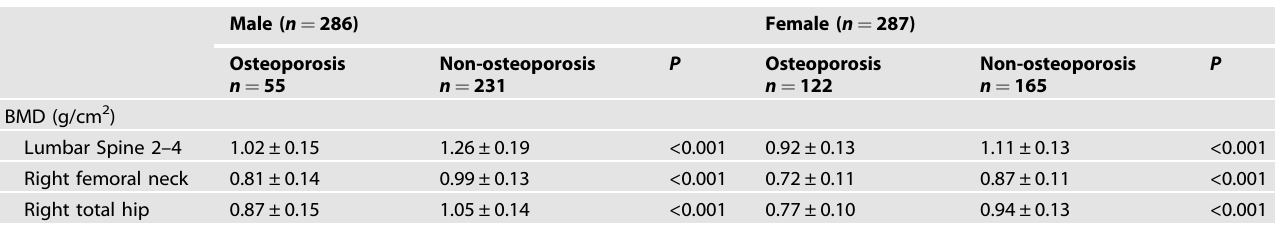
Table 2. BMD according to sex and osteoporosis